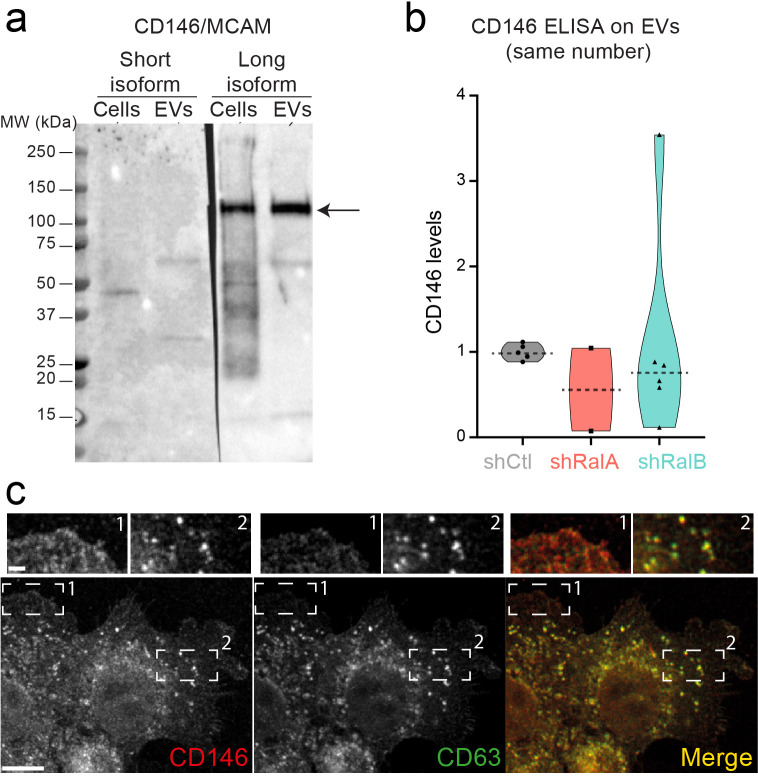
4T1 cells and extracellular vesicles (EVs) express CD146/MCAM long isoform.(a) Western blots on 4T1 cell and EVs extracts using antibodies selectively recognizing CD146/MCAM short (left) and long (right) isoforms. (b) Anti-CD146 Elisa on EVs isolated from shControl, shRalA, and shRalB cells. Each dot represents one replicate. Horizontal line represents the median. (c) Representative confocal images of 4T1 cells showing endogenous expression of CD146 and CD63 by immunofluorescence. Scale bars: 10 μm; zoom: 2 μm.